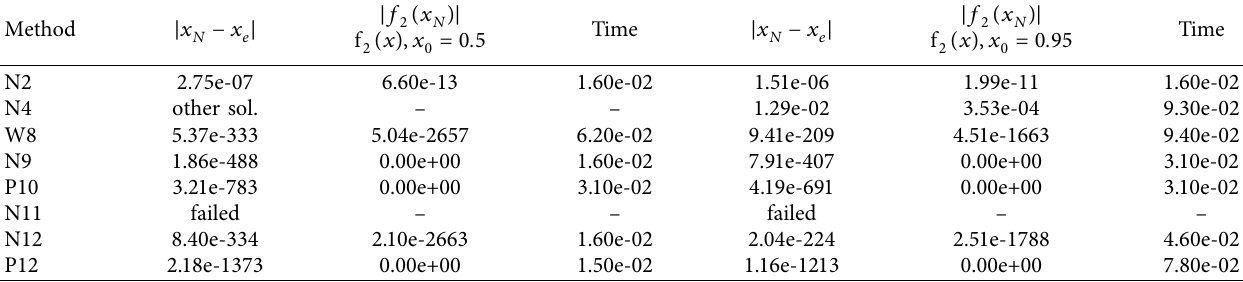
Table 2: Comparison of several methods with the same number of iterations ( N � 4 ) for the Problem 6. Method